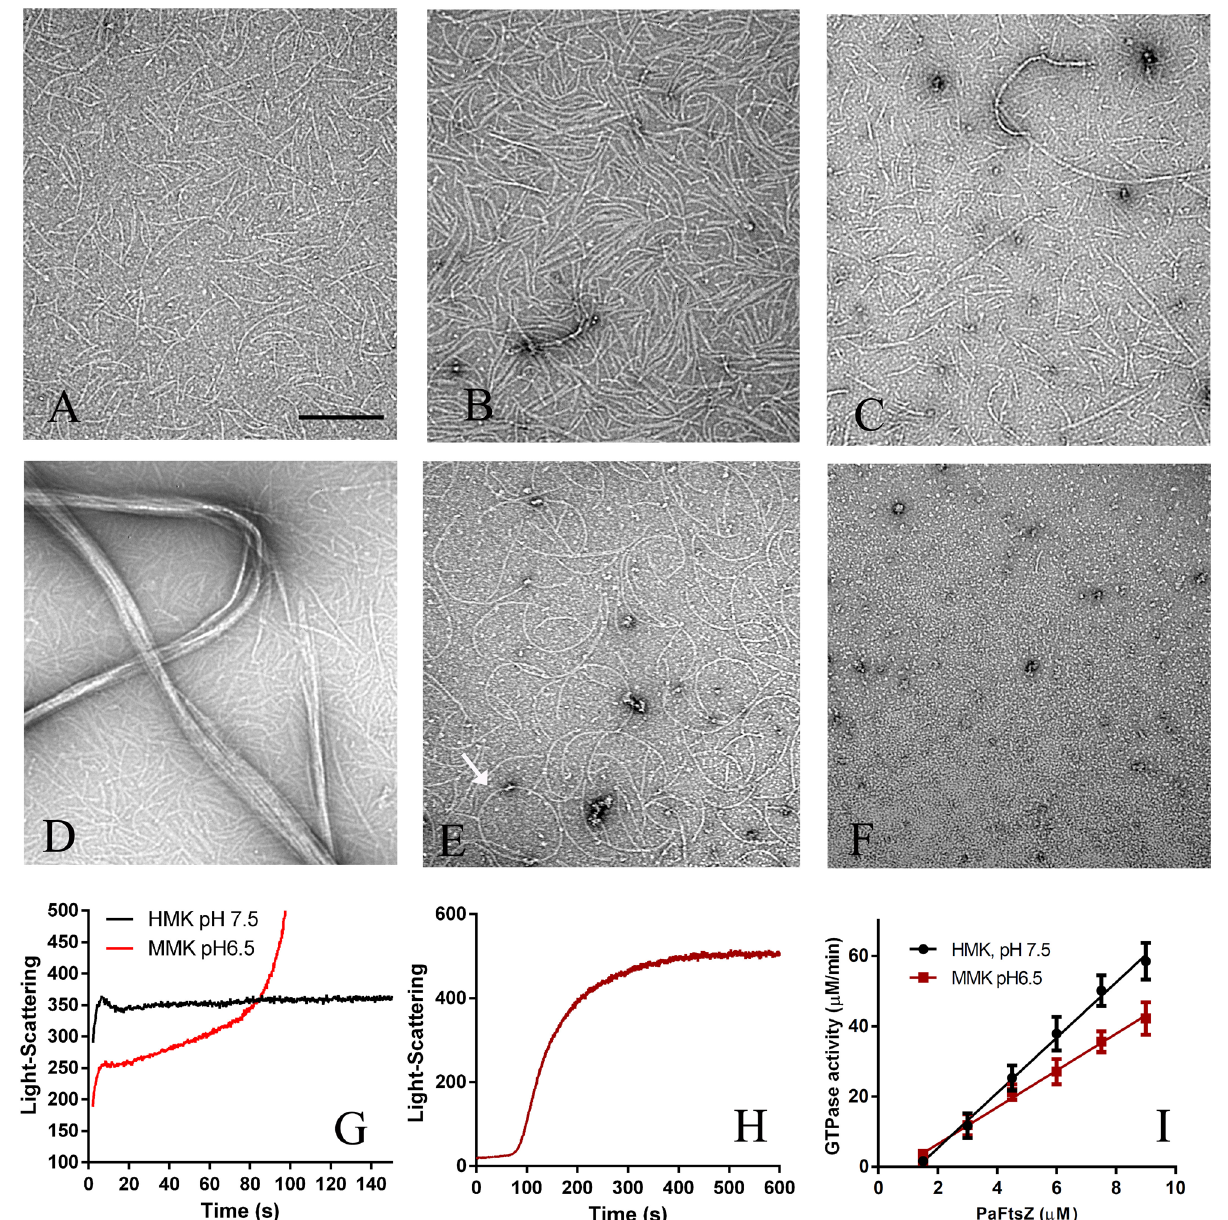
Figure 1. (A–F) Negative stain EM of PaFtsZ assembly in different buffer conditions. (A,B) 3 and 5 µM PaFtsZ in HMK (50 mM HEPES, 100 mM KAc, 5 mM MgAc, pH 7.5). (C,D) 5 µM PaFtsZ in MMK (50 mM MES, 100 mM KAc, 5 mM MgAc, pH 6.5) at 1 min (C) and 5 min after adding GTP (D) . (E) 5 µM PaFtsZ in MEK (50 mM MES, 100 mM KAc, 1 mM EDTA, pH 6.5). The arrow indicates a close circle. (F) 10 µM PaFtsZ in HEK (50 mM HEPES, 100 mM KAc, 1 mM EDTA, pH 7.5). The bar equals 200 nm and all EM images have the same magnification. (G,H) Assembly kinetics of 5 µM PaFtsZ measured by the light-scattering assay. PaFtsZ assembled mostly single filaments within 10 s in HMK buffer (G) , but in MMK buffer, it is a two-stage assembly: single filaments assembled within 10 s, followed by a second increase in light scattering attributed to bundling (H) . Assembly in MMK followed for a longer time and on a larger light scattering scale (H) . It is worth mentioning that the intensity values between (G) and (H) are not comparable. We reduce the sensitivity of the detector to measure the bundling formation (H) . (I) GTPase activity of PaFtsZ at different concentrations in HMK and MMK buffer. GTP is 0.5